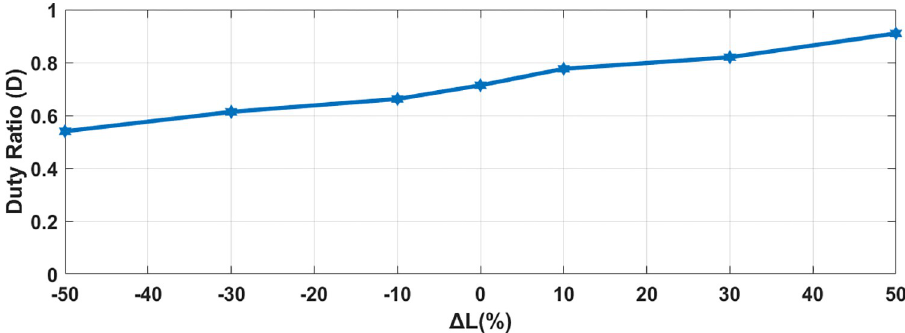
Fig 17. Sensitivity of proposed MPC controller to variations in inductor value for DC-DC